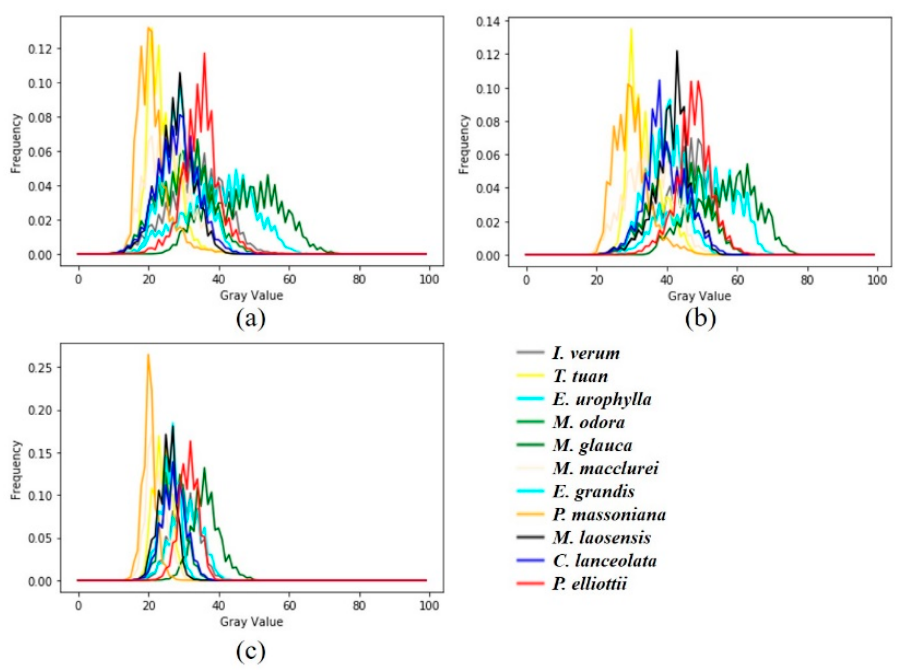
Figure 12. The histograms generated in the R, G, B, bands of 11 types of tree species. ( a ) The histograms in the R band. ( b ) The histograms in the G band. ( c ) The histograms in the B band.